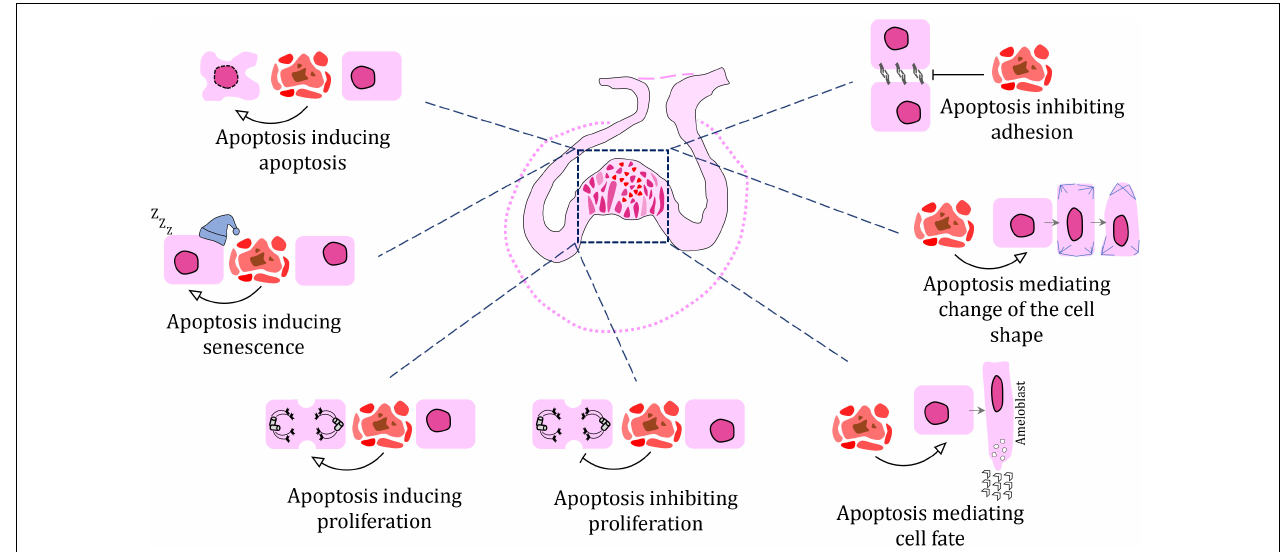
FIGURE 5 | Schematic of proposed cellular processes affected by apoptosis during odontogenesis as visualized at cap stage of molar tooth germ.